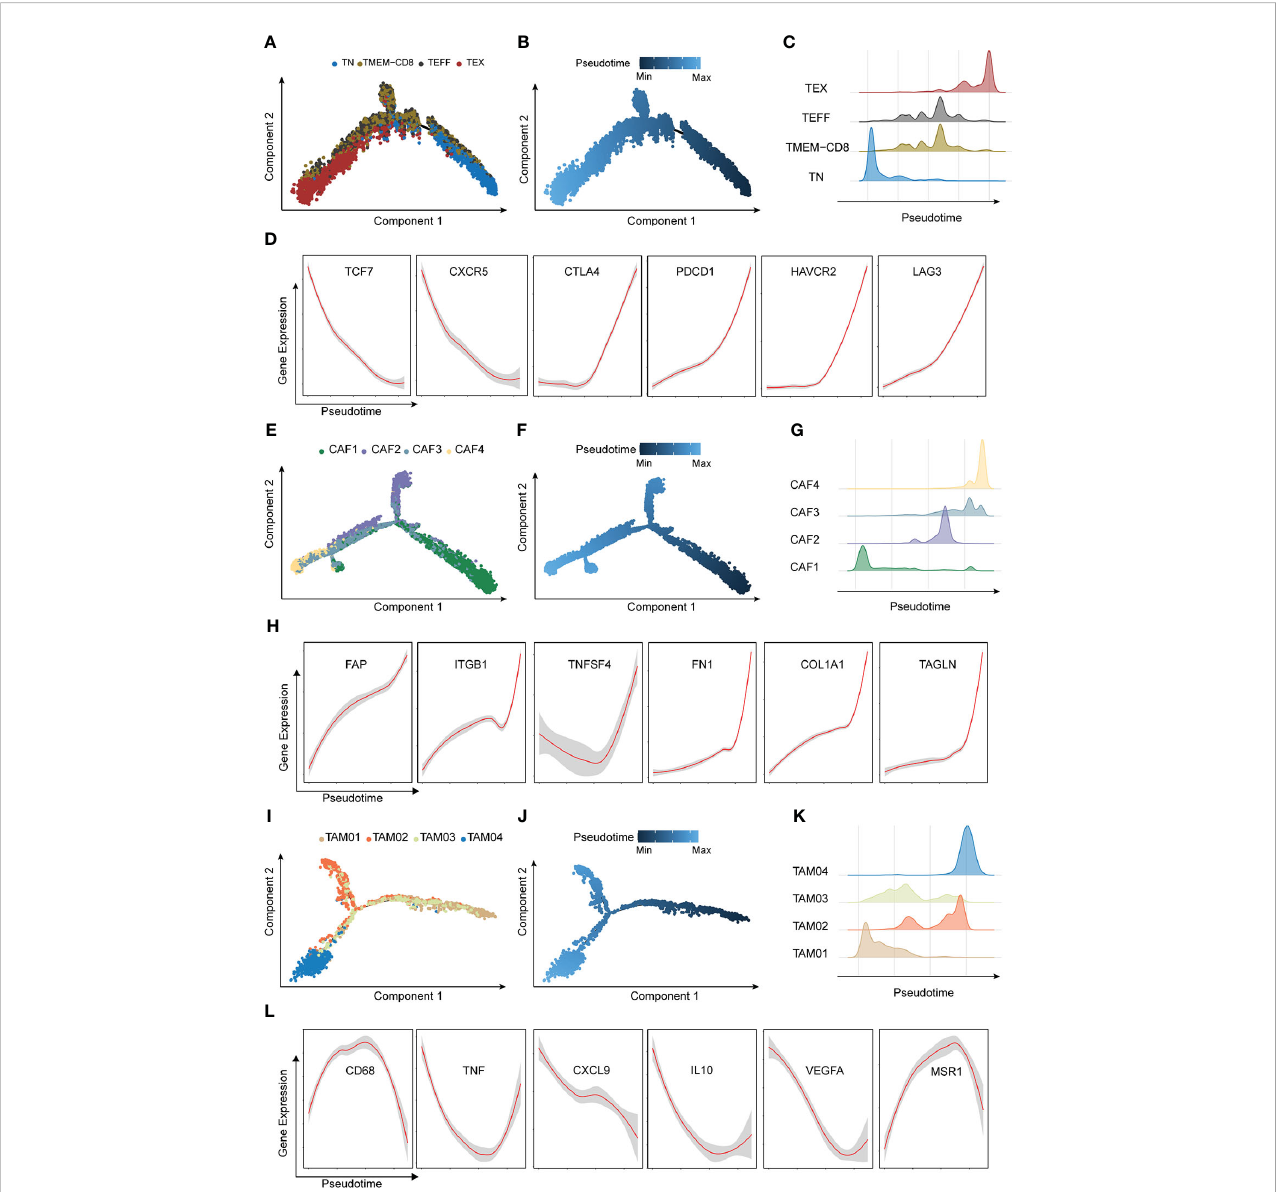
FIGURE 5 Characterization of major trajectories. (A) Pseudotime trajectory of CD8+T cells colored by cell types. (B) Pseudotime trajectory of CD8+T cells colored by pseudo-time. (C) Distribution of CD8+T cells. (D) Expression of CD8+T marker genes across pseudotime. (E) Pseudotime trajectory of cancer- associated fi broblasts colored by cell types. (F) Pseudotime trajectory of cancer-associated fi broblasts colored by pseudotime. (G) Distribution of cancer- associated fi broblasts. (H) Expression of tumor-associated macrophages marker genes across pseudotime. (I) Pseudotime trajectory of CD8+T cells colored by cell types. (J) Pseudotime trajectory of tumor-associated macrophages colored by pseudotime. (K) Distribution of tumor-associated macrophages. (L) Expression of tumor-associated macrophages marker genes across